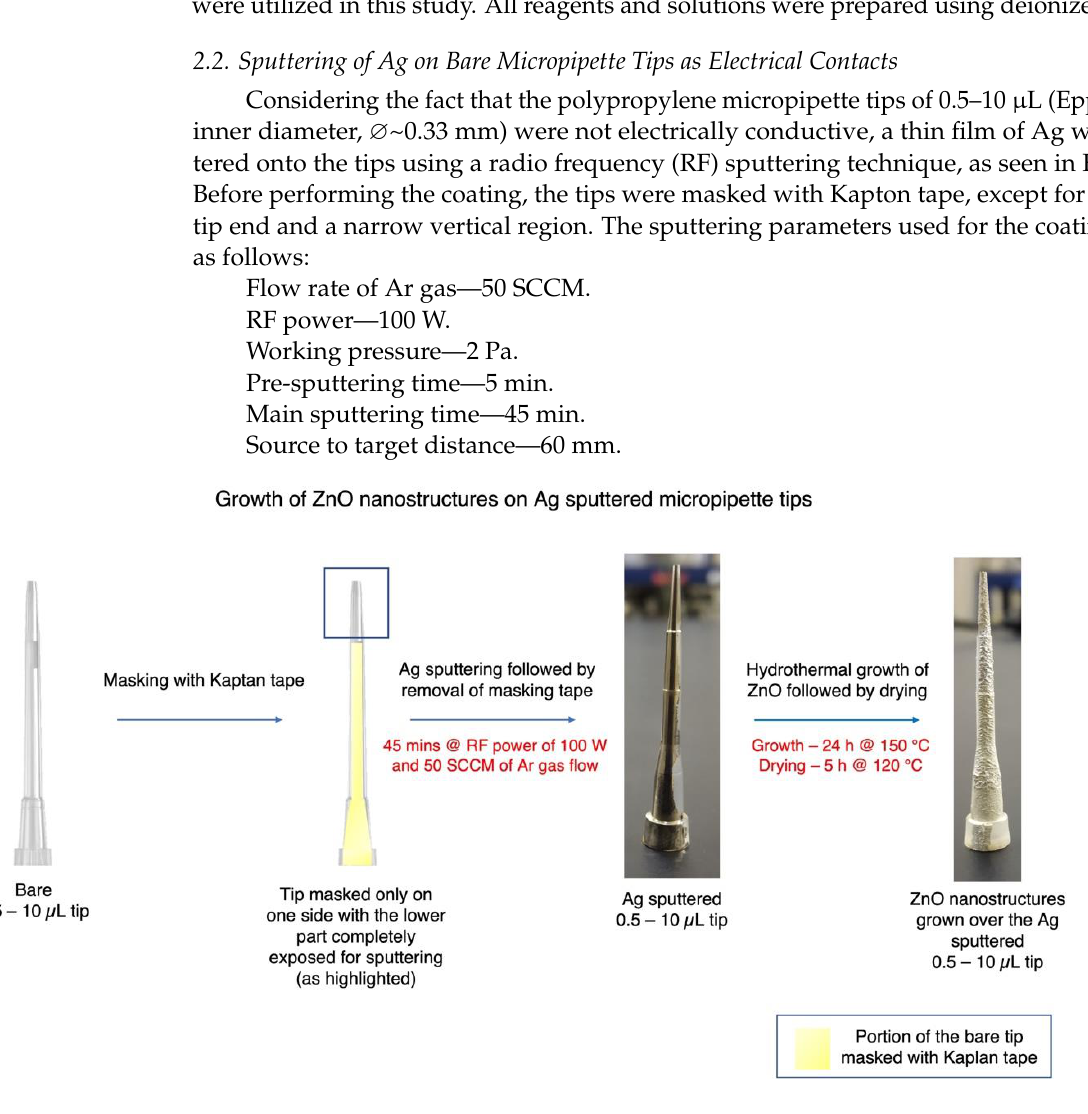
Figure 1. Illustration of the stages of modification of the bare micropipette tips (0.5 – 10 µL), starting from masking with Kapton tape, with only one side covered, leaving the other side and lower part completely exposed for sputtering. Subsequently, RF sputtering of Ag was performed for 45 min, followed by removing the masking tape. Finally, ZnO nanostructures were grown over the Ag- sputtered micropipette tips for 24 h at 150 °C, followed by drying for 5 h at 120 °C and several rinsing